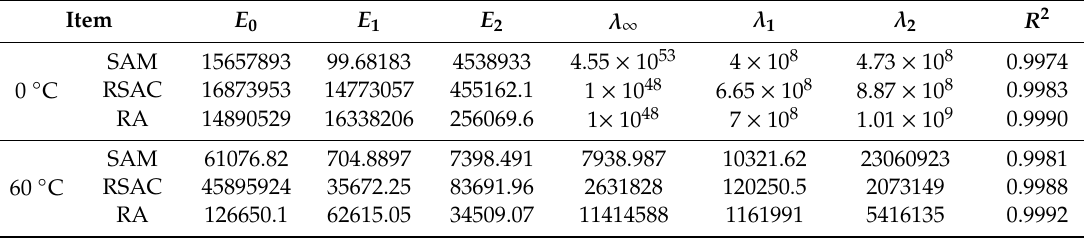
Table 9. Regression analysis of creep for modified asphalt samples in the second order Burgers model.